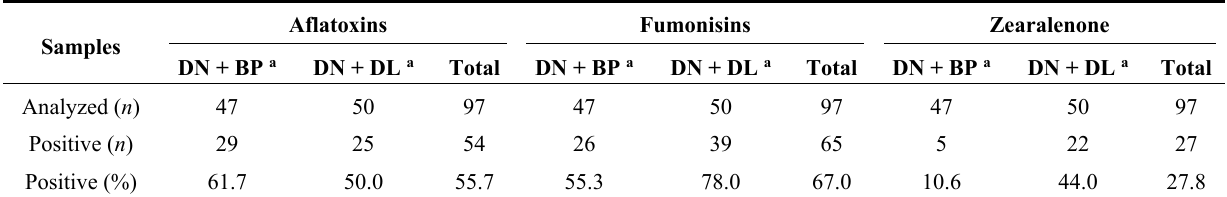
Table 1. Occurrence of aflatoxins, fumonisins and zearalenone in samples of maize from the Southeastern Mekong Delta Uplands and Central Highlands of